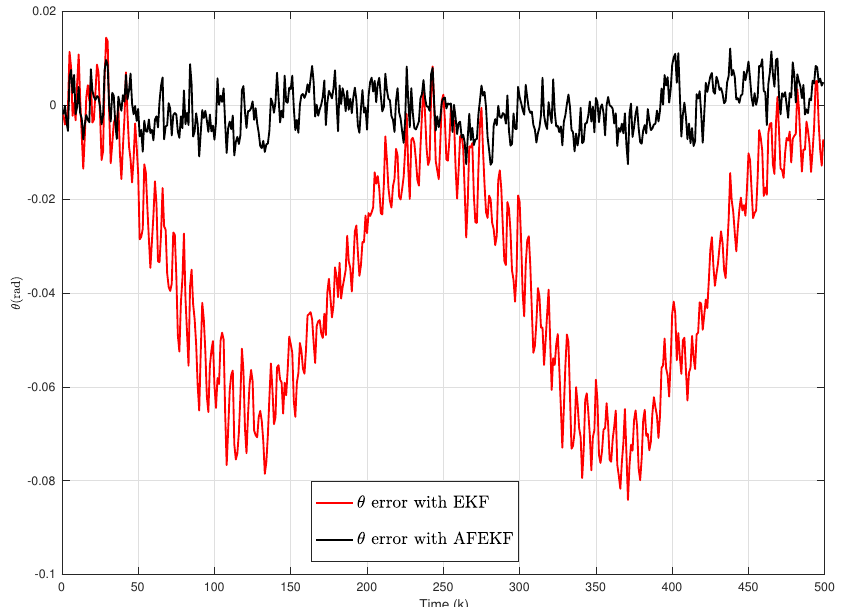
Figure 13. Robot’s angle errors under